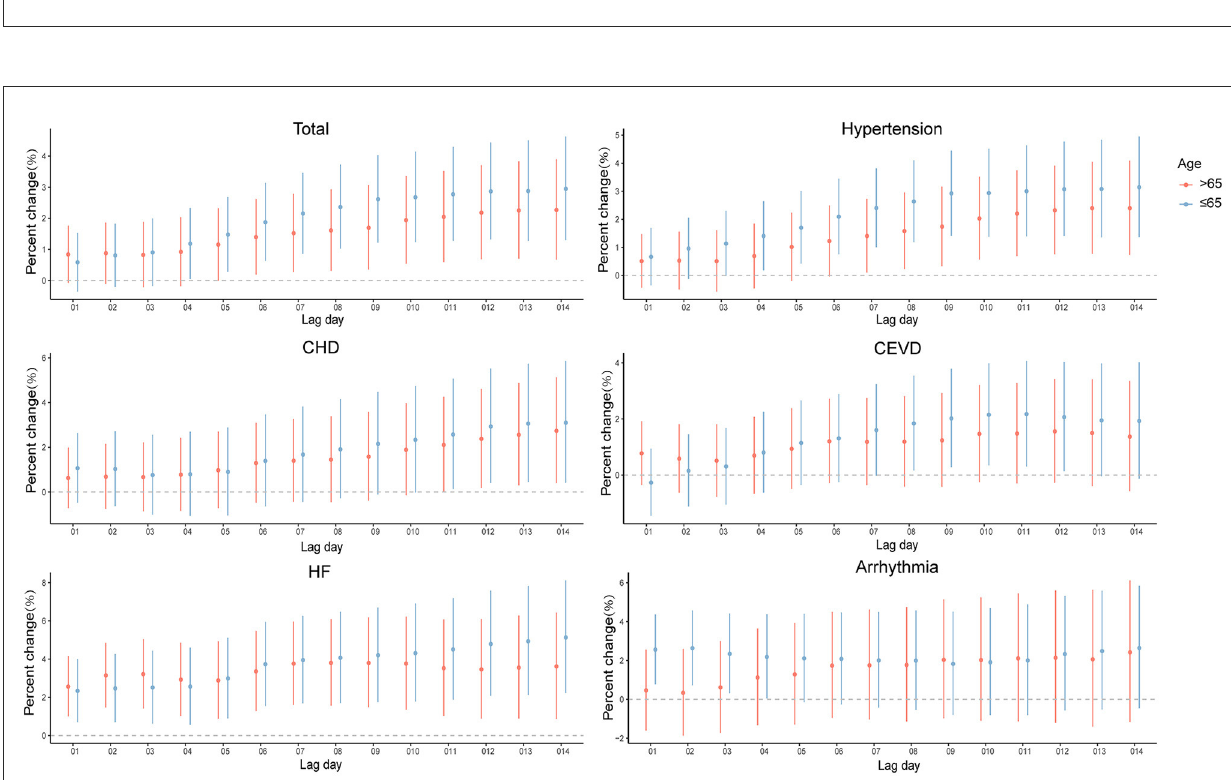
FIGURE3 Percent changes and 95% confidence intervals (CIs) of daily hospital admissions for total and cause-specific circulatory system diseases by each 10 µ g/m 3 increase of PM 2.5 concentrations stratified by gender at the cumulative-day lag models. HBP, hypertension; CHD, Coronary Heart Disease; CEVD, Cerebrovascular Disease; HF, Heart Failure.